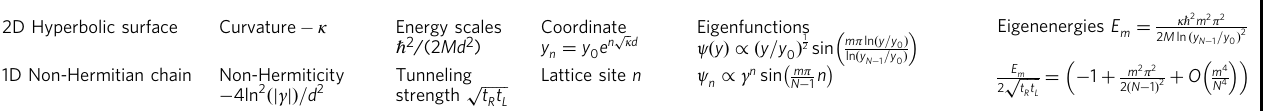
Table 1 The mapping between the continuum limit of the HN model near the band bottom under OBC and the Poincaré half-